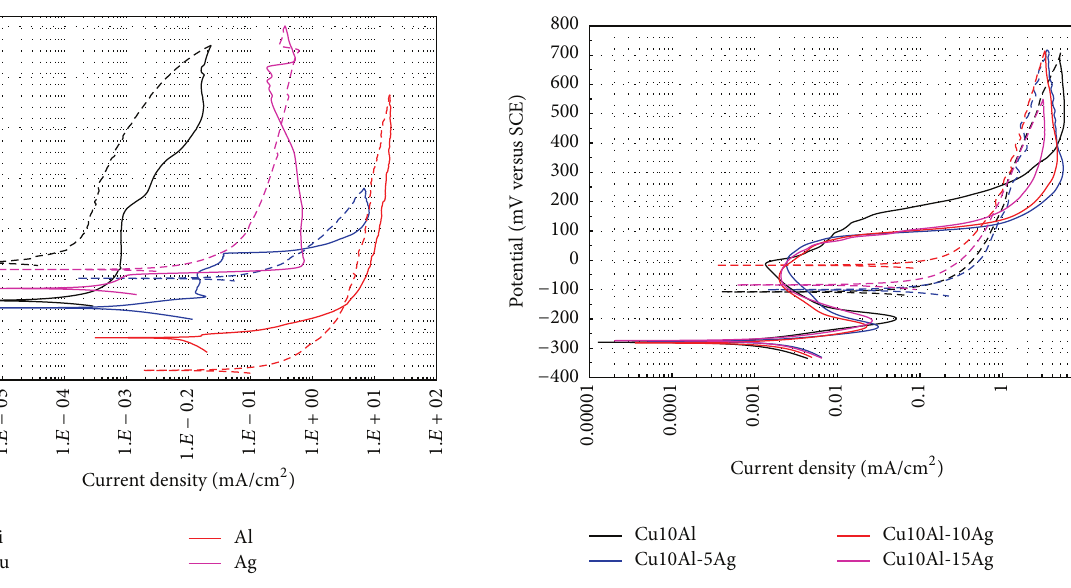
(hours)0 4540353025 Time